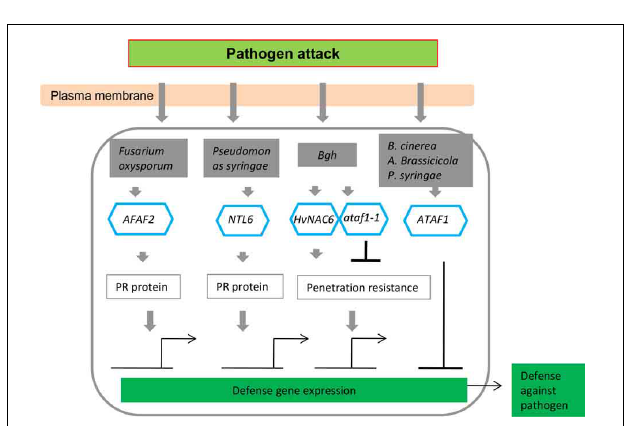
FIGURE 3 | NAC transcription factors as key components in the transcriptional regulation of gene expression during virus infection. Abbreviations: TCV, turnip crinkle virus; TIP, TCV-interacting protein; TLCV, tomato leaf curl virus; TMV, tobacco mosaic virus; WDV, wheat dwarf geminivirus.